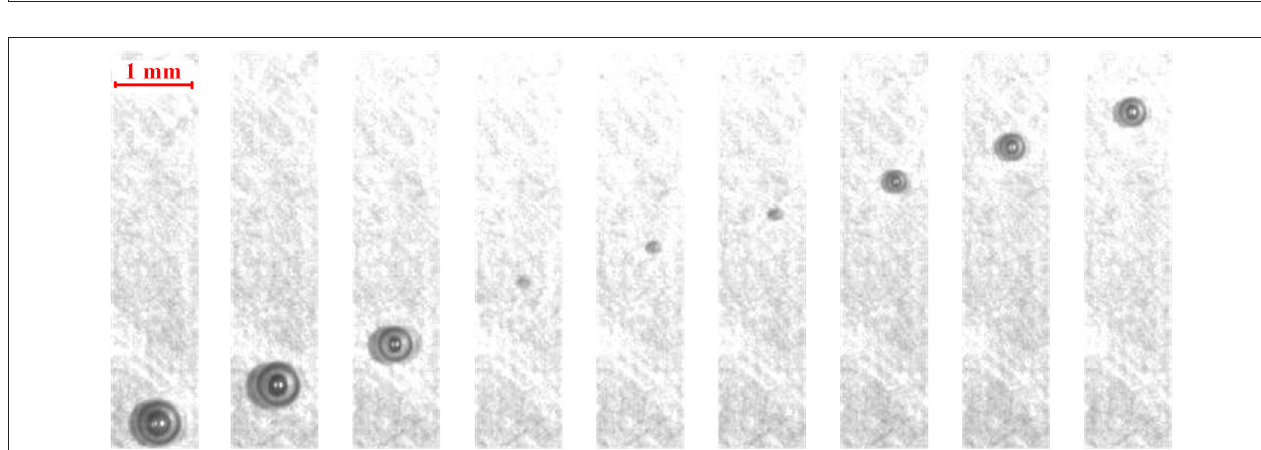
FIGURE 10 | Image sequence of bubble 4.